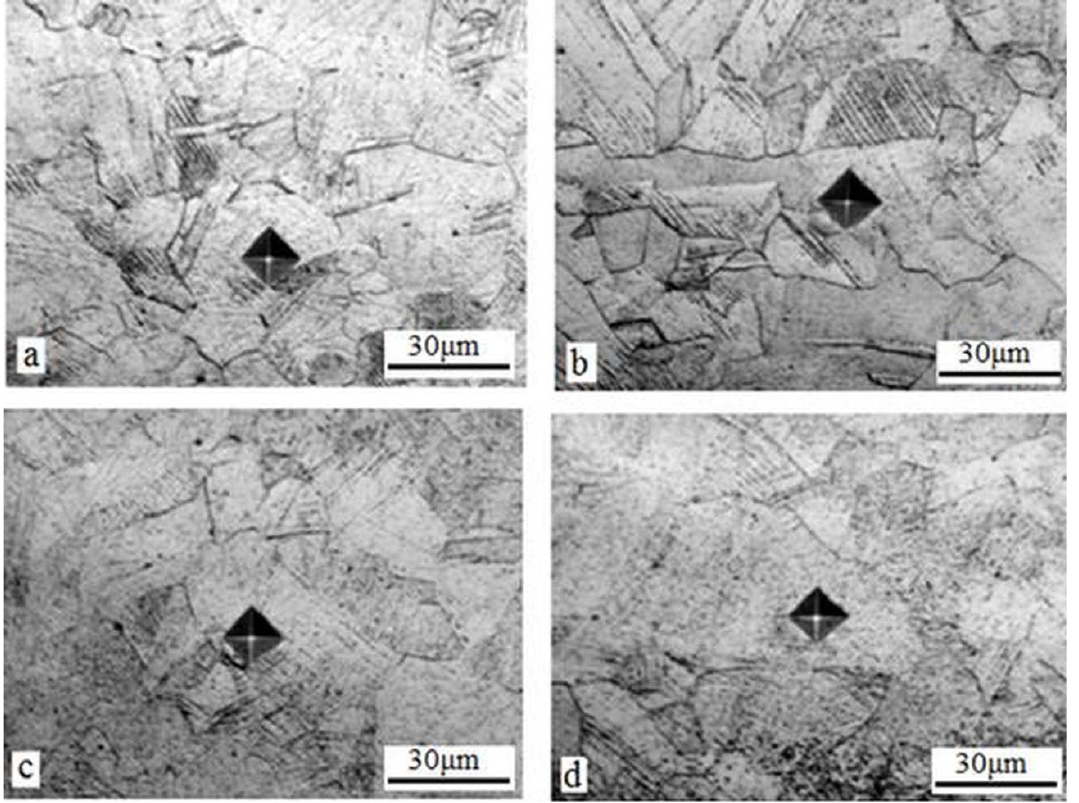
Figure 5. AISI 316L austenitic steel, a -d – the evolution of microstructure changes of the sample at a cross section as the friction surface approach. Friction duration - 10